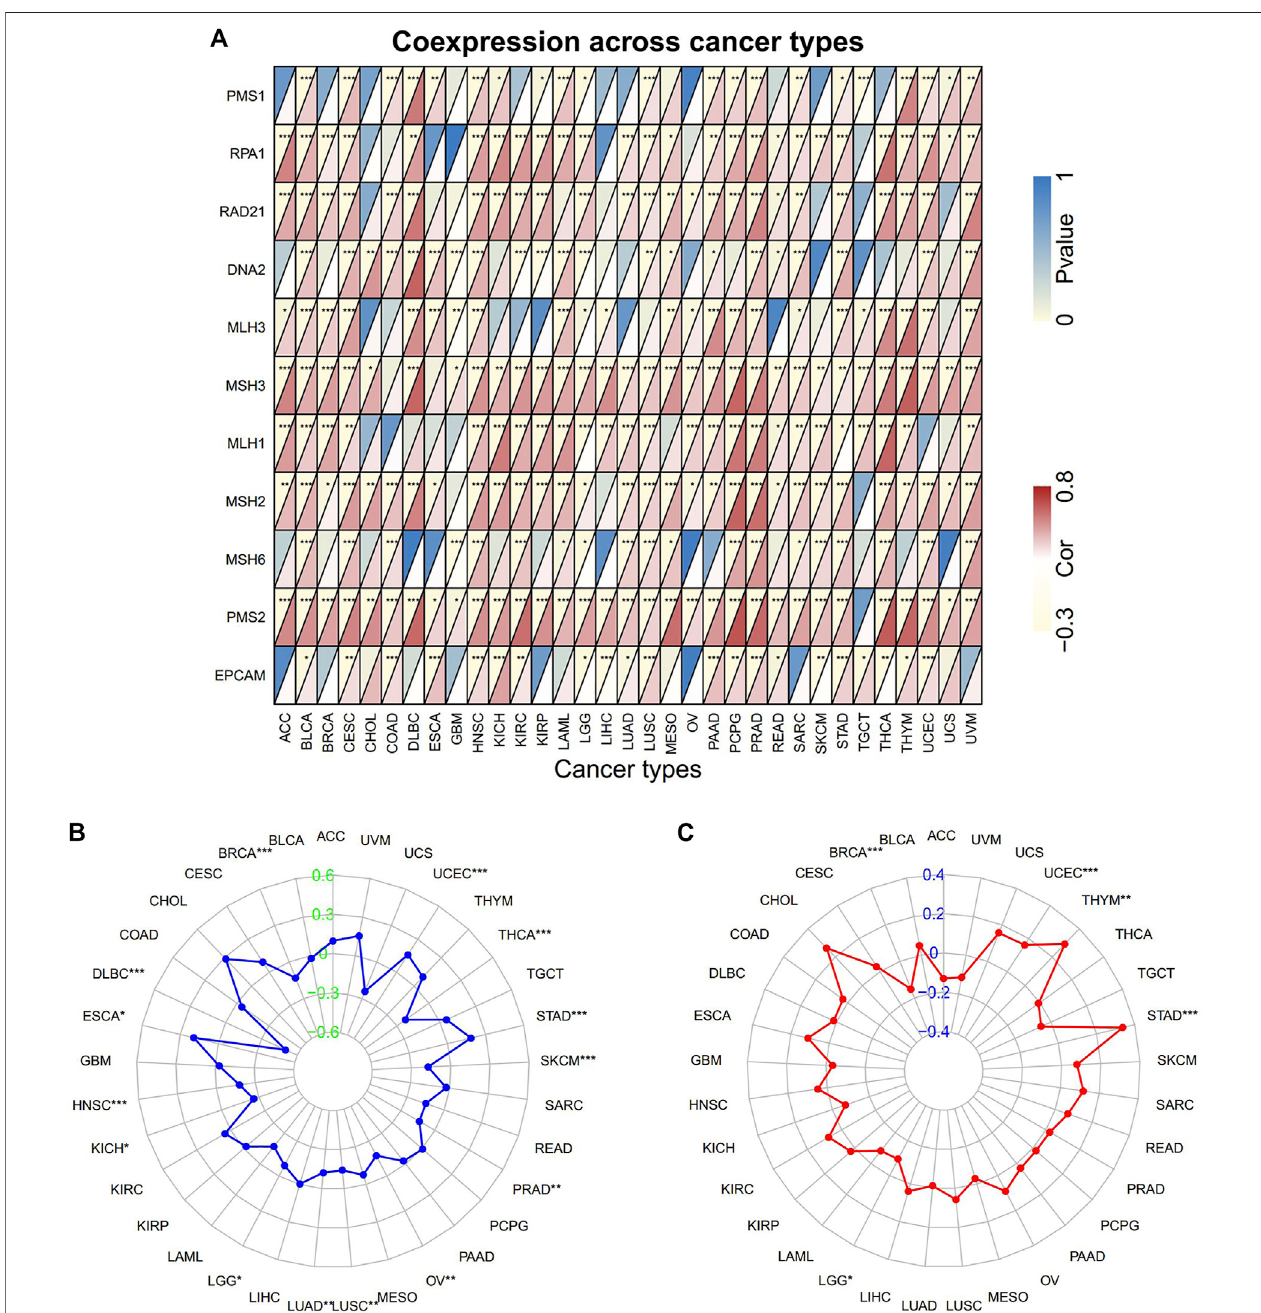
FIGURE5| ThecorrelationofPNPOexpressionwithimmune-relatedbiomarkers. (A) HeatmapindicatingthecorrelationbetweenPNPOexpressionandmismatch repair (MMR) genes. For each pair, the top left triangle indicates the p -value, and the bottom right triangle indicates the correlation coef fi cient. (B) Radar map of correlation between PNPO expression and microsatellite instability (MSI). (C) Radar map of correlation between PNPO expression and tumor mutation burden (TMB). * p < 0.05, ** p < 0.01, and *** p < 0.001.